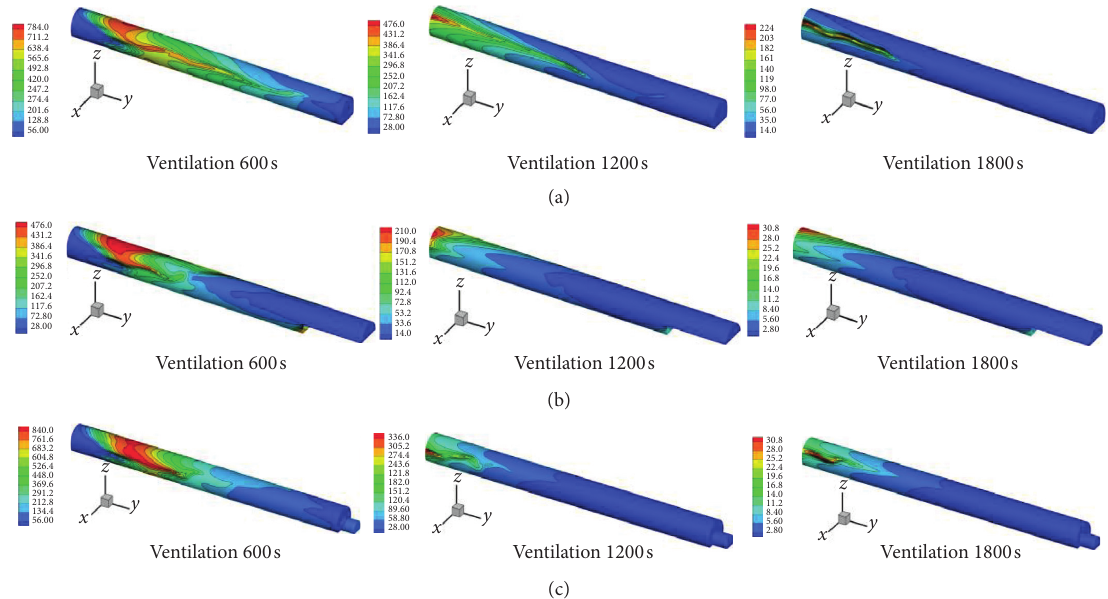
Figure 10: Influence of tunnel construction mode on CO diffusion characteristics (mg/m 3 ). (a) Full-section construction. (b) Step- construction. (c) Lower pilot heading construction.